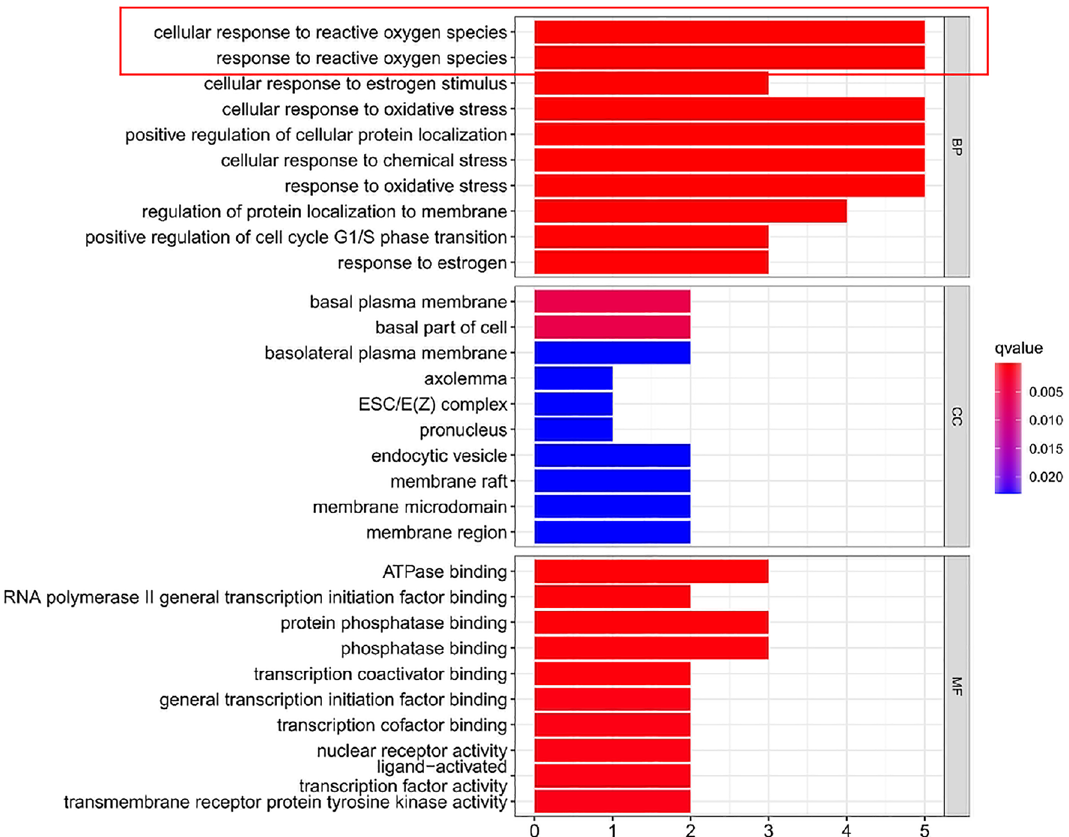
Figure 5. Advanced histogram of GO biological process analysis. In this study, 724 GO terms were identified, including 632 biological processes (BP), 26 cellular components (CC) and 66 molecular functions (MF). The top 10 most important terms for BP, CC and MF are clearly shown by the bar chart.